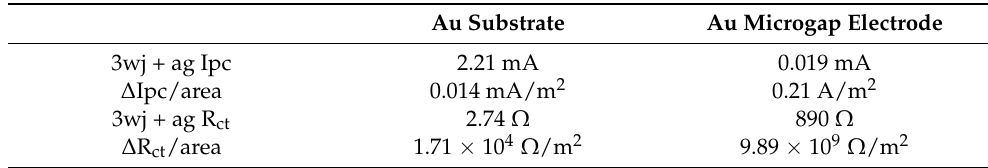
Table 1. Comparison of the electrochemical performances of the Au substrate and the Au micro- gap electrode.